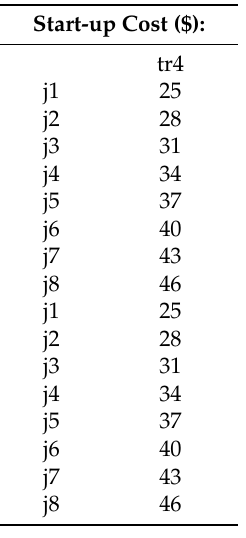
Table A4. Cost steps in start-up cost curve of unit i ($) suc_sw( i , j ).